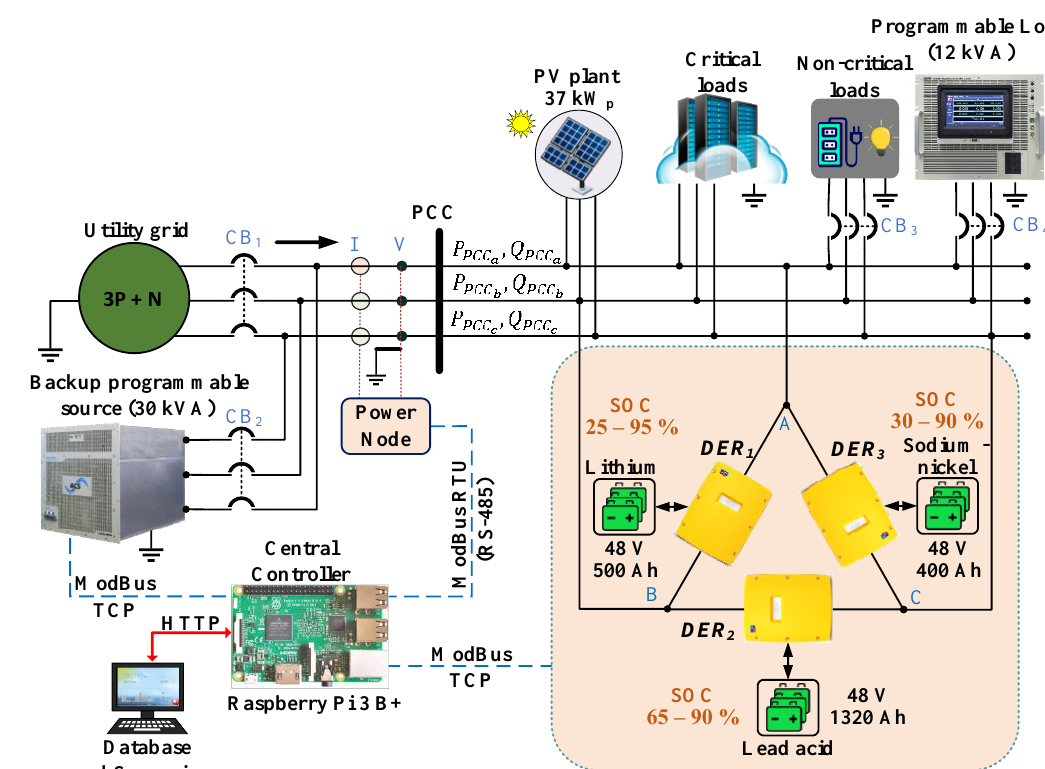
Figure 1. Block diagram of the single-controllable microgrid.